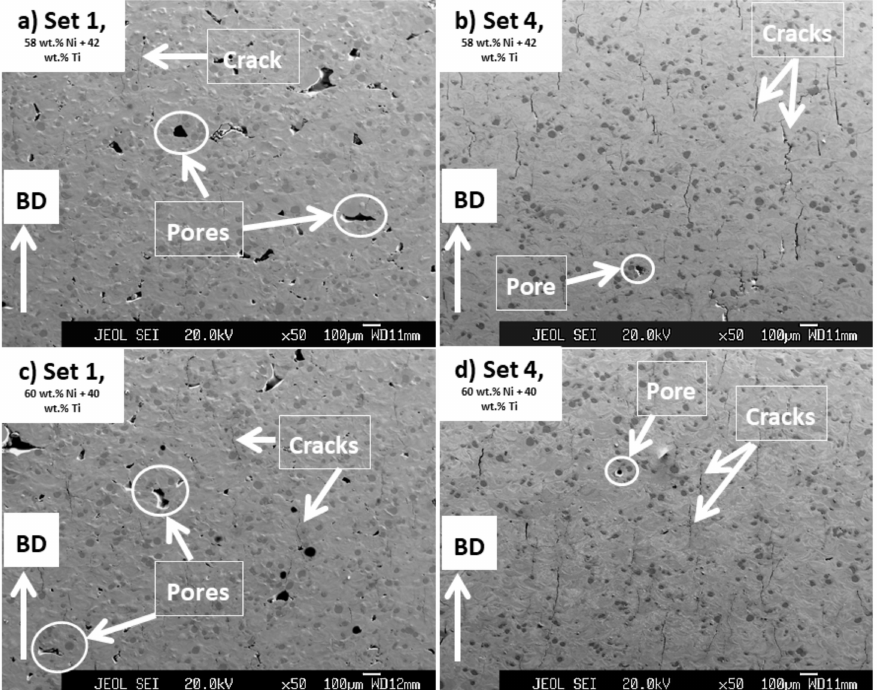
Figure 4. Images obtained from the cross-section of samples processed from powder mixtures having ( a , b ) 58 wt.% Ni + 42 wt.% Ti and ( c , d ) 60 wt.% Ni + 40 wt.% Ti compositions by processing sets 1 and 4 having energy inputs of 27.70 and 39.68 J/mm 3 , respectively. Some of the cracks and pores seen in the microstructure of these samples are shown in the images.